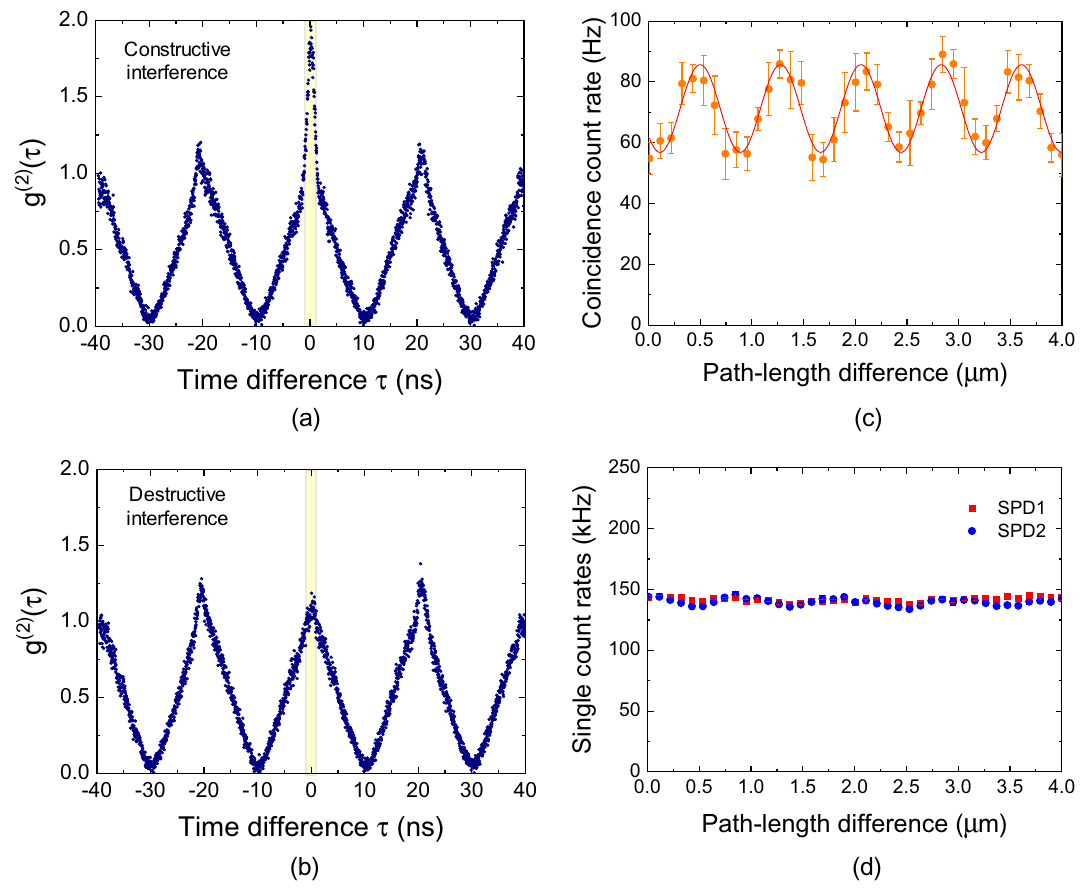
Figure 4. Temporal waveforms of thermal light obtained with Franson-type interferometer. Experimental (blue dots) and theoretical (red curves) results for ( a ) the constructive SOI condition of φ L φ S SOI condition of φ L π. ( c ) SOI fringe of the thermal light as a function of the path-length difference − = between both unbalanced Michelson interferometers (Δ x 1 changed and fixed at Δ x 2 = 0). ( d ) Single count rates of SPD1 (blue circles) and SPD2 (red circles) as a function of the path-length